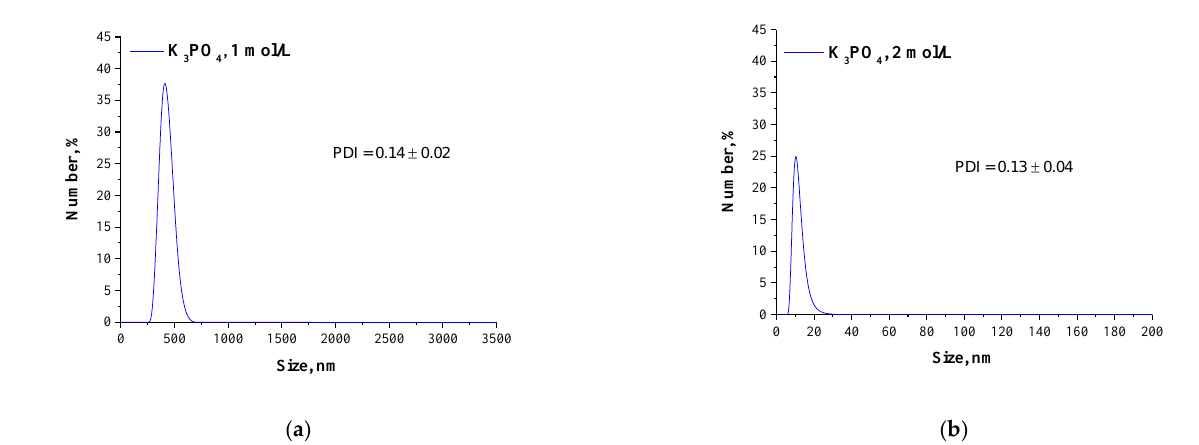
Figure 2. DLS analysis of particles obtained using Tris-HCl buffer with pH = 4.8 and 1 mol/L K 3 PO 4 ( a ) or 2 mol/L K 3 PO 4 ( b ) as a salting-out agent.